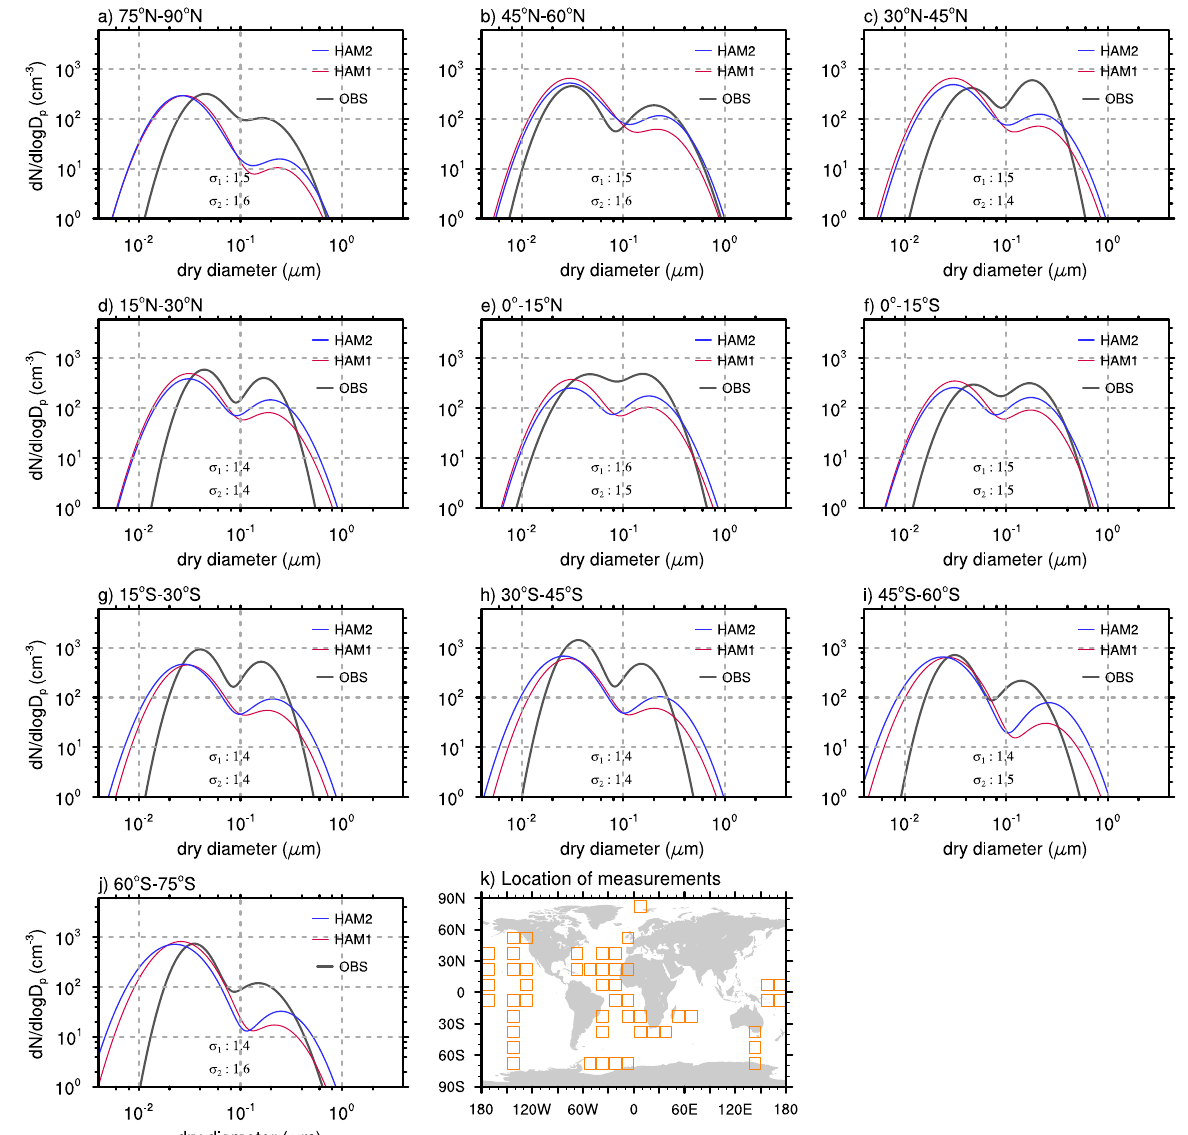
Fig. 16. Comparison of the measured (black curves) and simulated (colored curves) size distribution functions of the Aitken and accumulation modes (soluble and insoluble) in the marine boundary layer. The observations are a 30-yr climatology covering the brown boxes shown in (k) , compiled by Heintzenberg et al. (2000). The simulations shown in red and blue correspond to the HAM1 and HAM2 simulations, respectively. σ 1 and σ 2 in each panel are the observed standard deviation of the Aitken and accumulation mode. In the HAM model a fixed value of 1.59 is prescribed for both